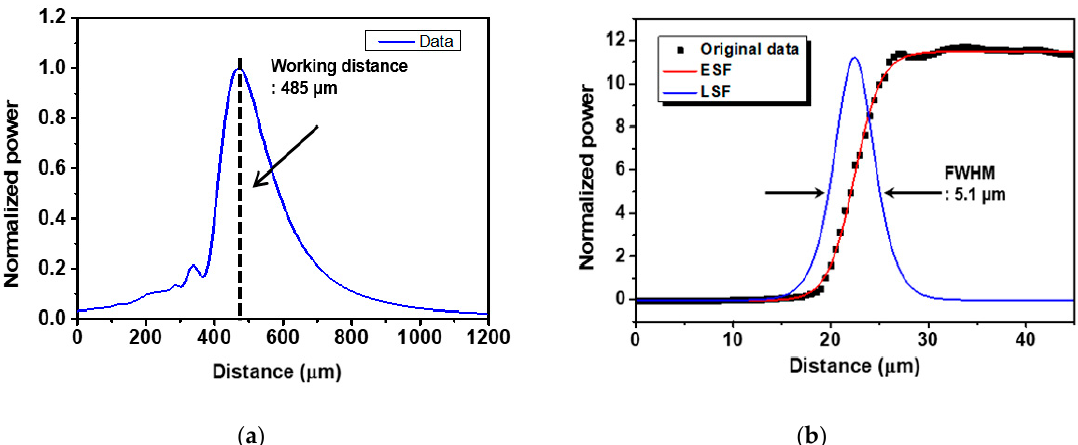
Figure 5. ( a ) Optical coupling power graph. The optical power of the back-reflected beam from a mirror that was moved away from the DCF lens tip was measured. ( b ) Measurement of the line spread function (LSF) using the knife-edge mirror. Black square-shaped symbols indicate the original data measured by the same method that was used for determining the optical coupling power in ( a ); red solid line indicates the edge spread function (ESF) obtained by line fitting the original data; blue solid line indicates the LSF obtained by measuring the first derivative of the ESF along the scanning direction.